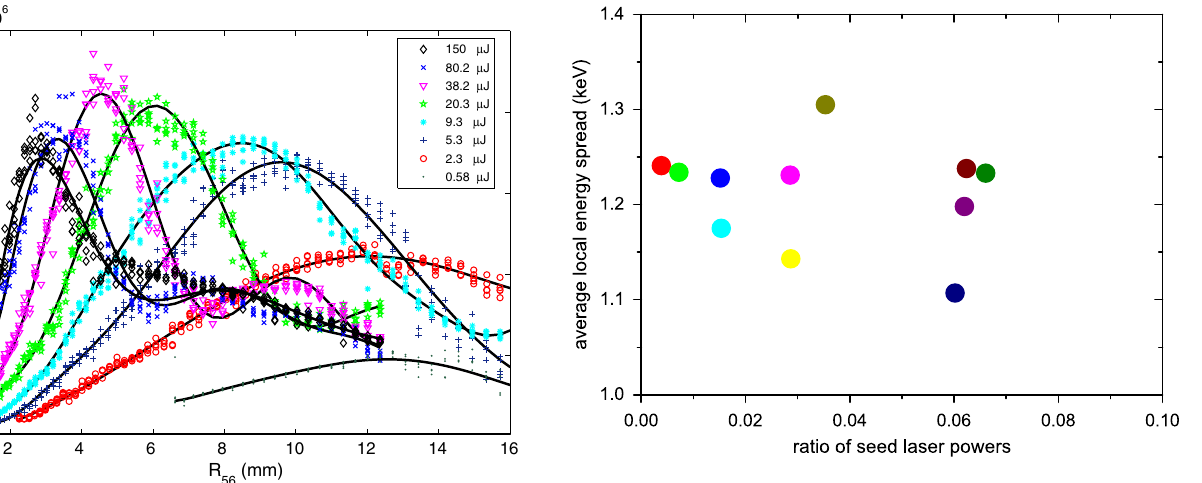
FIG. 11. Calculation results of the average local energy spread based on the measurement curves with the ratios of seed laser powers are less than 0.1 (or bigger than 10).